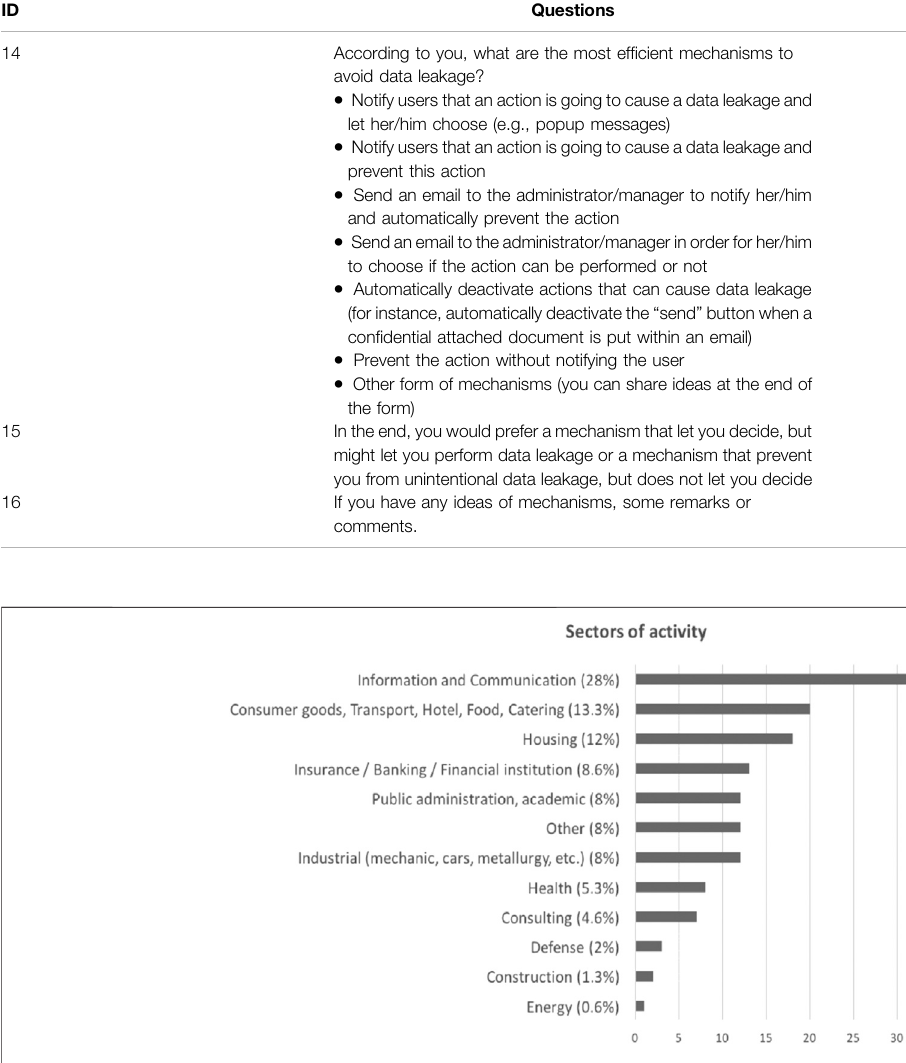
FIGURE 1 | Distribution of the different sectors of activity.